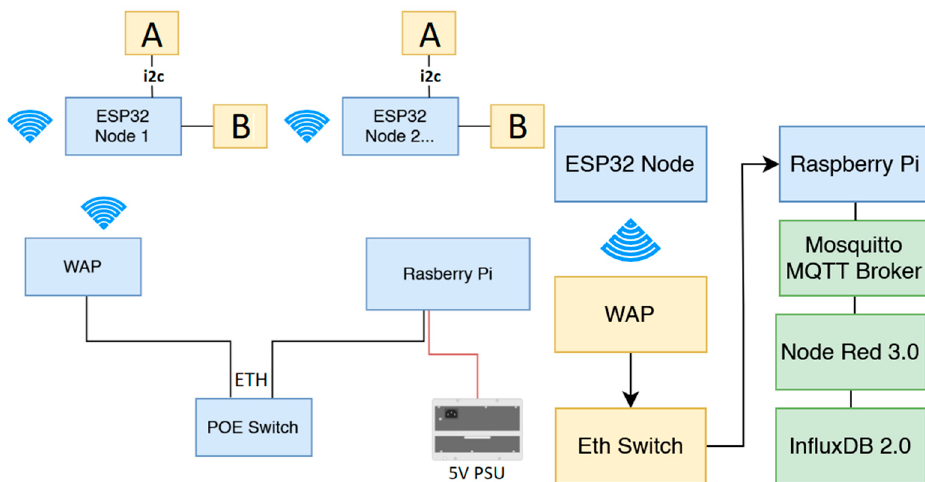
Figure 4. Digital architecture for the sensor network, A: SCD-30 sensor, B: 18650 batteries, WAP: wireless access point, POE: power over ethernet, ETH: ethernet.